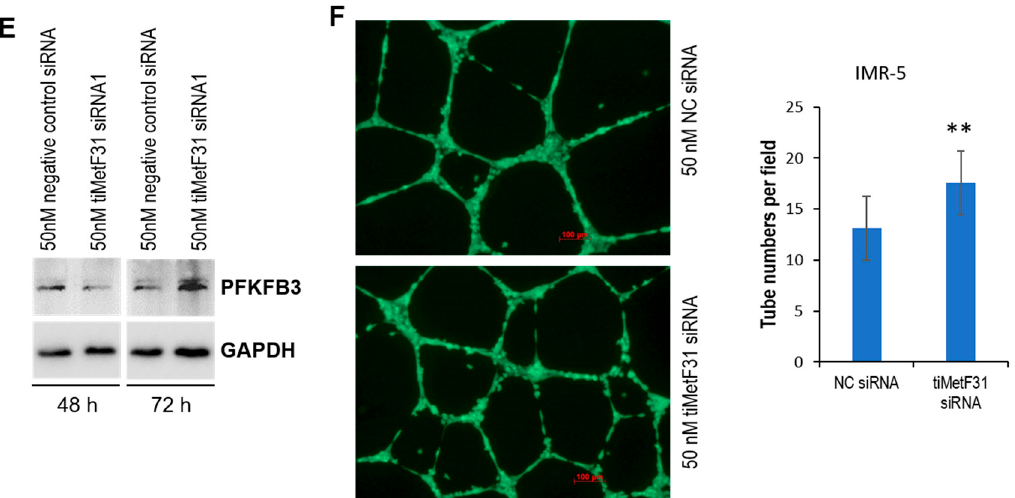
Figure 6. tRiMetF31 inhibits migration and angiogenesis of neuroblastoma cells. ( A ) IMR-5 cells were transfected with 50 nM of either WT-tRiMetF31 or Scr-tRiMetF31. Cells were treated with 10 μ g/mL mitomycin C for 2 h prior to injury, and wound-healing assay was performed as described in Section 4. Data were expressed as mean ± SD for five migration images. ( B ) Tube formation assay was carried out with 50% conditioned medium from IMR-5 transfected with 50 nM of either WT-tRiMetF31 or Scr-tRiMetF31, as detailed in Section 4. Representative images were taken using a fluorescence microscope (100×). Data were expressed as mean ± SD for five images. ( C ) SK-N-AS cells were transfected with 50 nM of either WT-tRiMetF31 or Scr-tRiMetF31. Cells were treated with 10 μ g/mL mitomycin C for 2 h prior to injury, and wound-healing assay was performed as described in Section 4. Data were expressed as mean ± SD for five migration images. ( D ) Tube formation assay was carried out with 50% conditioned medium from SK-N-AS cells transfected with 50 nM of either WT-tRiMetF31 or Scr-tRiMetF31 as detailed in Section 4. Representative images were taken using a fluorescence microscope (100×). Data were expressed as mean ± SD for five images. ( E ) IMR-5 cells were transfected with 50 nM of either tRiMetF31 siRNA or negative control siRNA. At 48 and 72 h after transfection, whole cellular lysates were prepared and subjected to Western blotting with antibody to PFKFB3, and GAPDH served as a loading control. ( F ) Tube formation assay was carried out with 50% conditioned medium from IMR-5 cells transfected with 50 nM of either tRiMetF31 siRNA or negative control siRNA as detailed in Section 4. Representative images were taken using a fluorescence microscope (100×). Data were expressed as mean ± SD for five images. *, p < 0.05; **, p < 0.01. Original western blot data is shown in Figure S3.